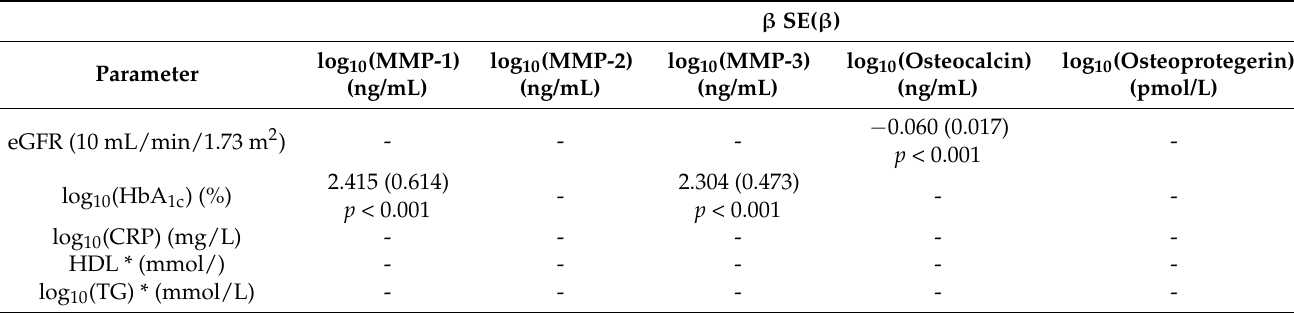
Figure 3. The associations between HbA 1c concentration and MMP-3 activity. The value of log HbA 1c of 0.78 corresponds to HbA 1c level = 42 mmol/mol (6.0%), log HbA 1c of 0.9—to HbA 1c level = 64 mmol/mol (8.0%), and log HbA 1c of 1.0—to HbA 1c level = 86 mmol/mol (10%). The multivariate stepwise backward regression analysis revealed that variabilities of MMP-1 and MMP-3 values were explained by log HbA 1c , whereas OC variability only by eGFR (Table 3). Table 3. Factors influencing concentrations of circulating markers of vascular remodeling- stepwise backward regression